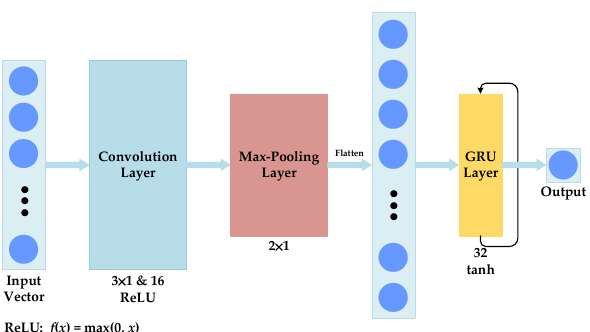
Figure 2. The structure of the convolutional neural network incorporated into GRU with deep sequential structure (CNNGRU).